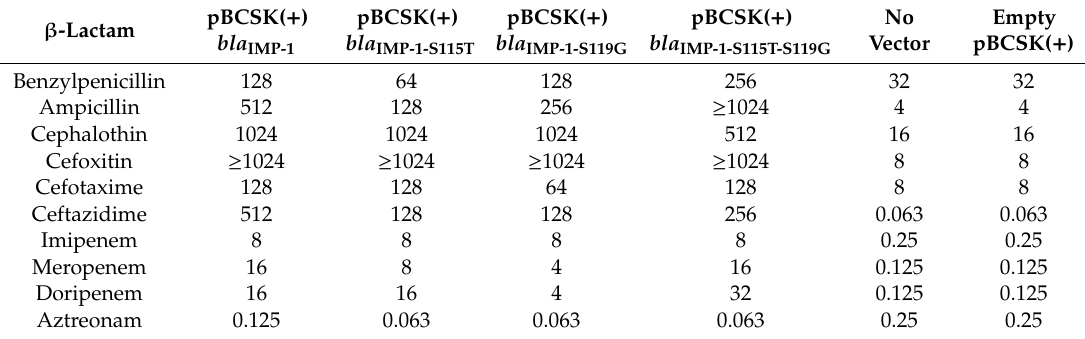
Table 1. MICs ( µ g / mL) of a range of antibiotics. Medians of four replicates are reported. Table 1. MICs (µg/mL) of a range of antibiotics. Medians of four replicates are reported. β β -Lactam